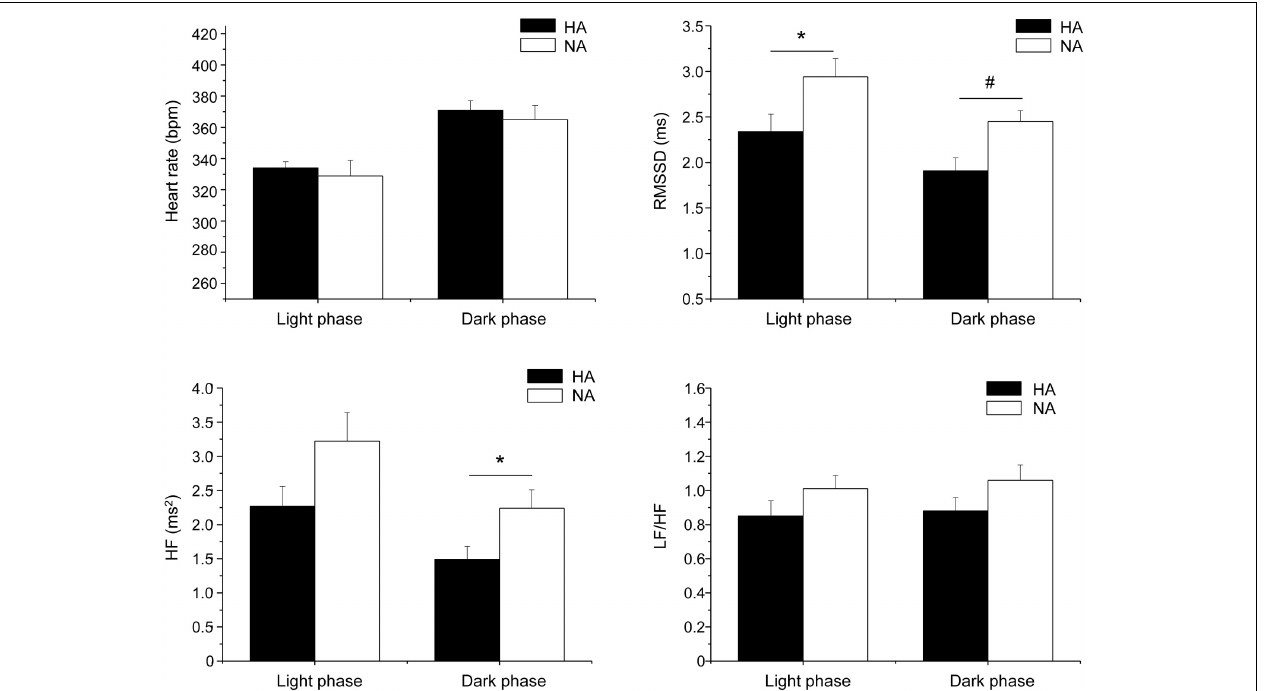
FIGURE 6 | Daily rhythms of heart rate, RMSSD, spectral power in HF band (0.75–2.5Hz) and LF (0.2–0.75Hz) to HF ratio in high-aggressive (HA, n = 10) and non-aggressive (NA, n = 10) Wild-type rats. For the 12 hours-light and 12 hours-dark phases, values are reported as means ± s.e.m.